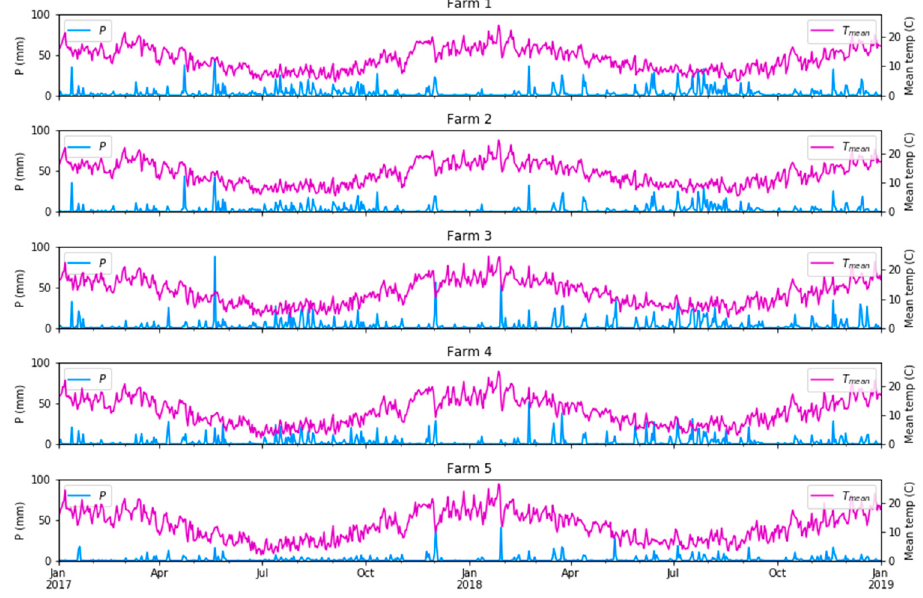
Figure 5. Daily precipitation and mean temperature ( T mean = ( T max + T min )/2) in the five farms under study.